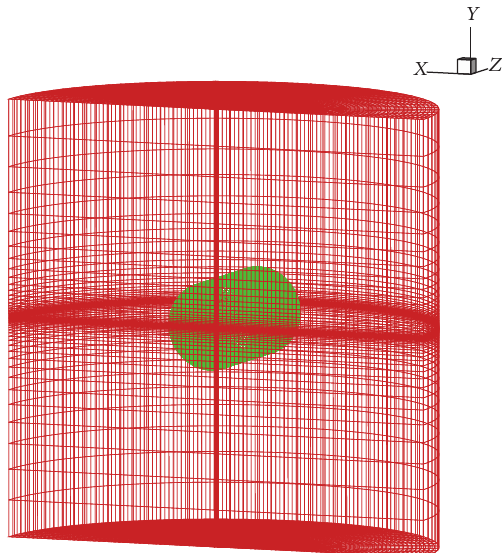
Figure 1: Diagram of overlapping grids used in flow field calcula-